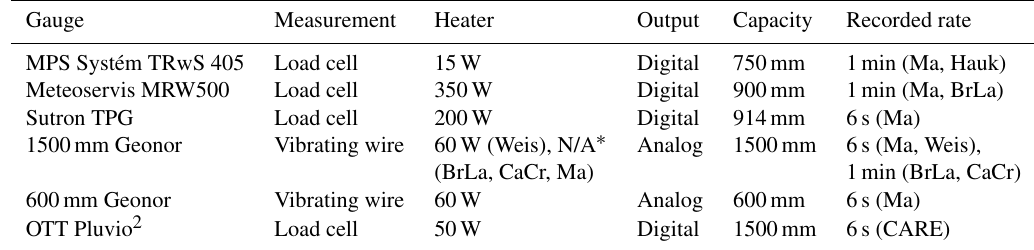
Table 1. Gauge type, measurement type, heater power, output type, gauge capacity, and the recorded rate of the different types of gauges included in this evaluation. The recorded rate was determined by the logging system at a given site, and was not intrinsic to the gauges. Test beds incorporated in the study include the following: the Centre for Atmospheric Research Experiments, Canada (CARE); Caribou Creek, Canada (CaCr); Bratt’s Lake, Canada (BrLa); Marshall, United States (Ma); Haukeliseter, Norway (Hauk); and Weissfluhjoch, Switzerland (Weis).